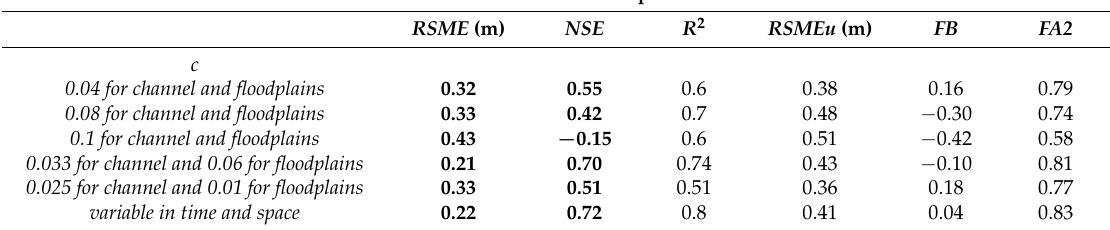
Table 9. Results of hydraulic simulation model calibration performance for 3 December 2013: the relative value of the Manning coefficients c , Root Mean Square Error RMSE , Nash- Sutcliffe Efficiency Coefficient ( NSE ), coefficient of determination R 2 , Unsystematic RSME RSMEu , fraction bias FB, prediction within a factor of two of observation FA2